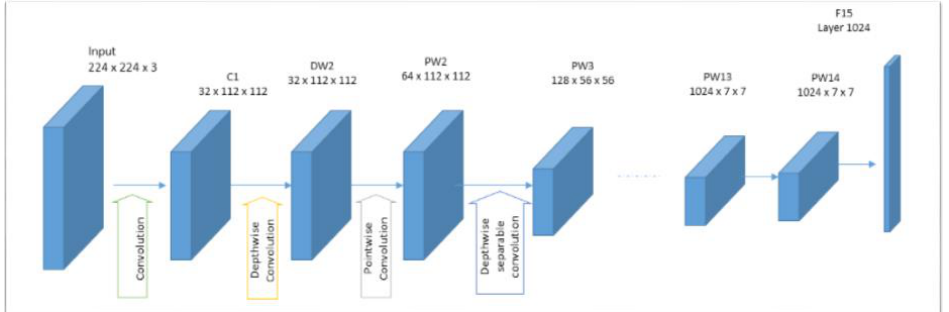
Figure 3. MobileNet architecture.